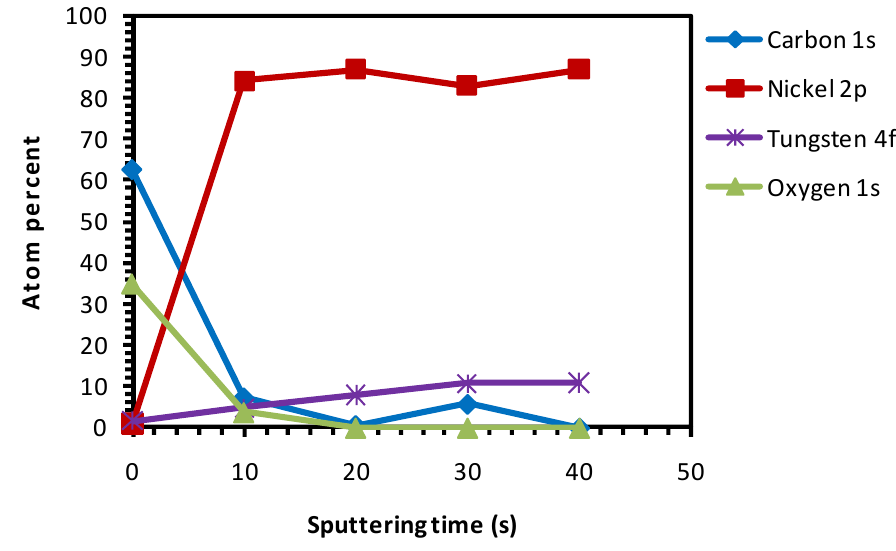
Figure 7. XPS depth profile studies of Ni-5% W substrate after thermal cleaning.